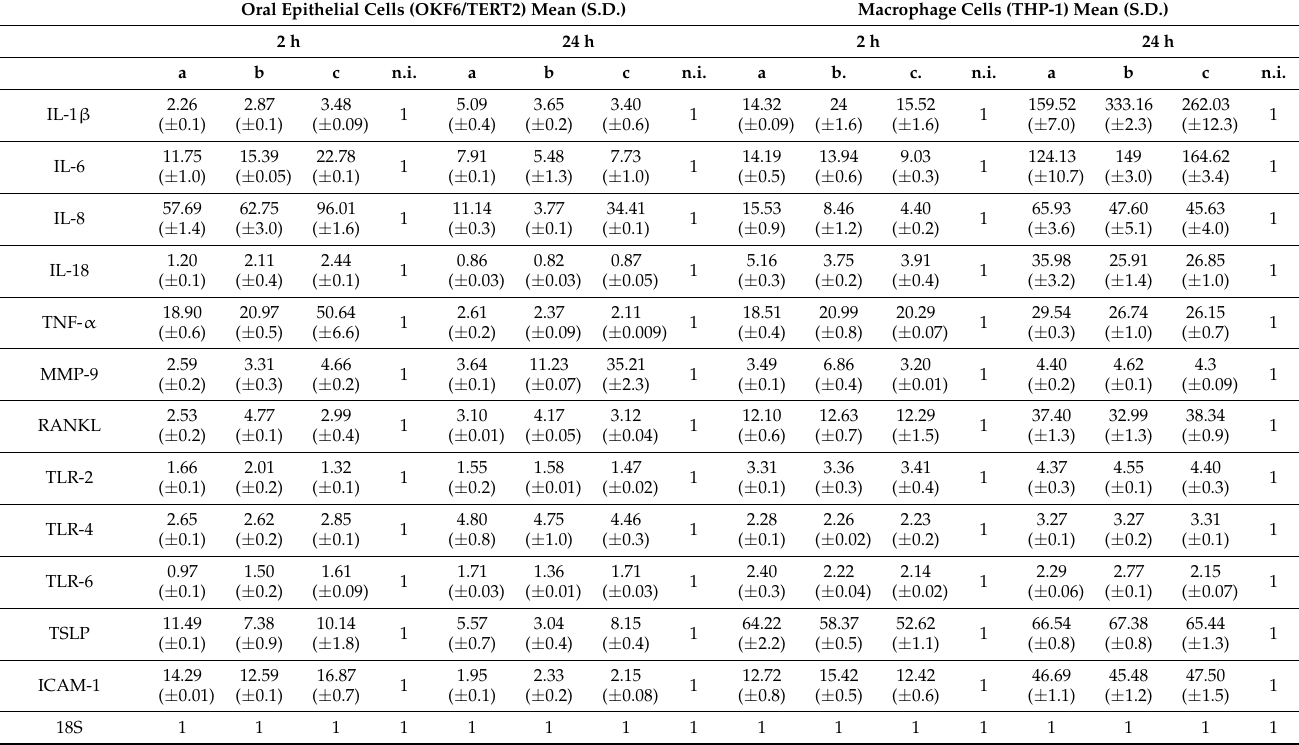
Data are represented as fold-change for 3 independent experiments, mean and standard deviation (S.D.) for each condition are showing. For relative expression, mRNA expression in non-infected (n.i.) macrophages and oral epithelial cells were considered as 1, as a reference for fold-change in expression using 18S rRNA expression levels as a normalizing endogenous control. ( a : Sereotype a, b : Serotype b, c : Cerotype c, n.i. : Non-infected